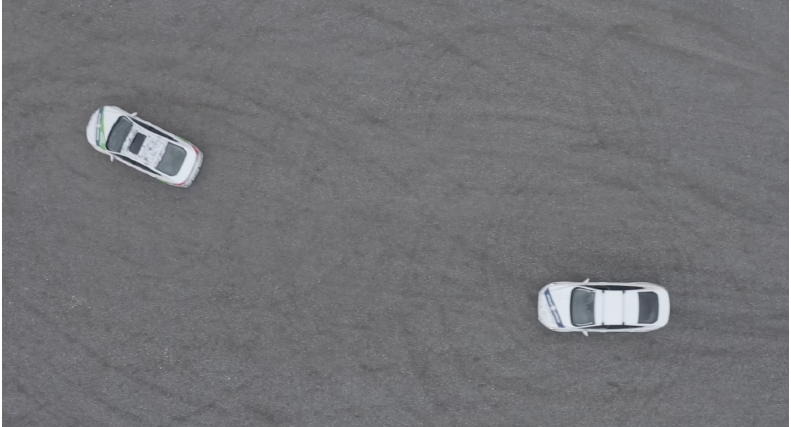
Figure 5. Bird’s-eye view of the leader (left) and follower (right) vehicle setup, taken during the field tests. Video footage is available online at https://youtu.be/0EnHqTouIuc (Accessed on 1 May 2022).